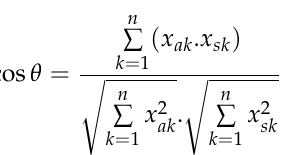
Table 1. Summary statistics for brominated compounds in Antarctic air in the vicinity of Casey and Troll Stations, where the mean concentration (fg/m 3 ) is obtained only from samples in which compounds were detected at >LOQ. The % Detection is the percentage of samples that were >LOQ, and non-detect (ND) denotes concentrations <LOQ. Casey Troll Compound Mean ( ± SD) Range % Detection Mean ( ± SD) Range % Detection